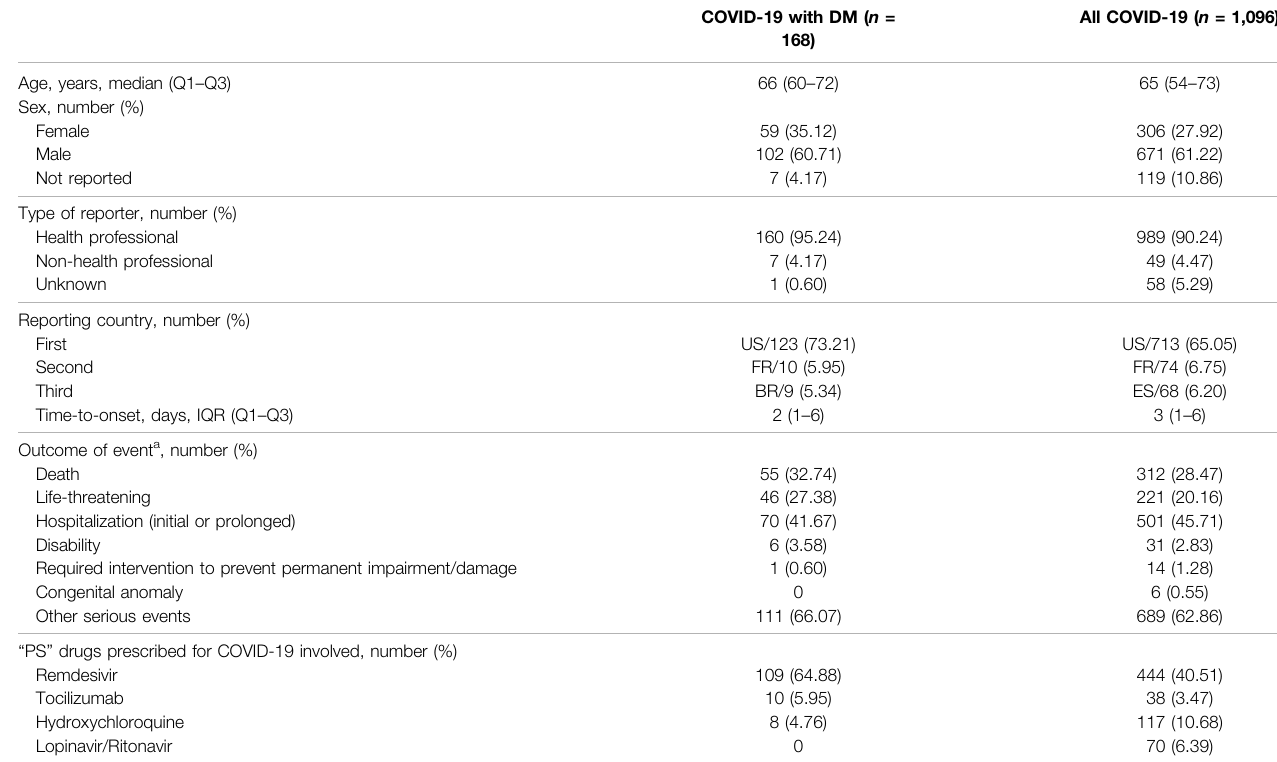
TABLE 1 | Characteristics of patients who experienced AKI.